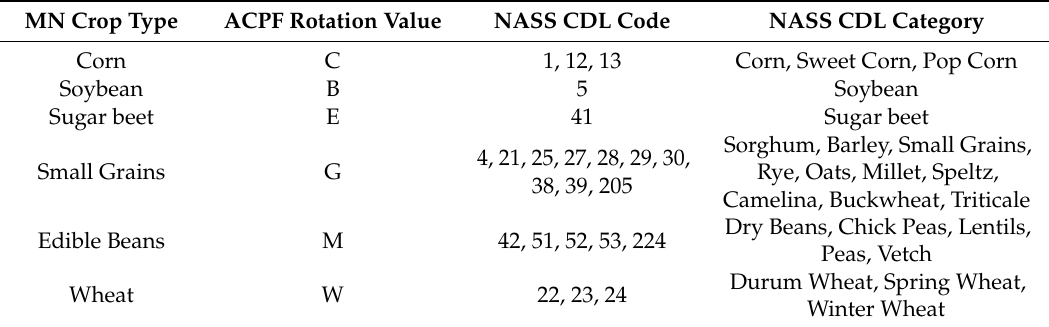
Table 1. Minnesota (MN) Major Crop Types and Associated Agricultural Conservation Planning Framework (ACPF) and Cropland Data Layer (CDL)